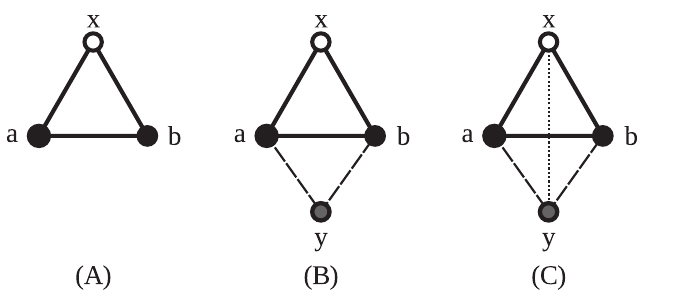
Fig 8. Construction of an equation. The white vertex is the orbit representative ’ s marked vertex, black vertices were present in the original orbit representative and the gray vertex is the new vertex. Full lines indicate the original edges, dashed lines the edges added as part of the common neighbors and dotted lines the vertices that are added afterwards. (A) G ( x ) ’ Orbit representative 3. (B) G ( x ) [ {{ y , a }, { y , b }} ’ Orbit representative 12. (C) G ( x ) [ {{ y , a }, { y , b }, { y , x }} ’ Orbit representative 14.